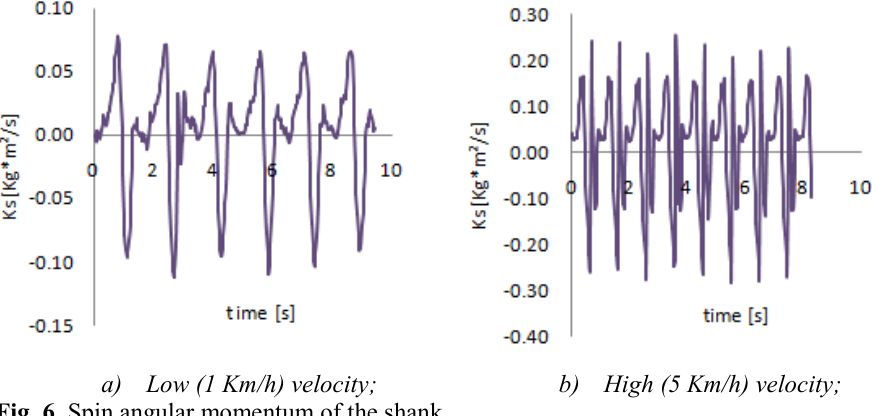
Fig. 6. Spin angular momentum of the